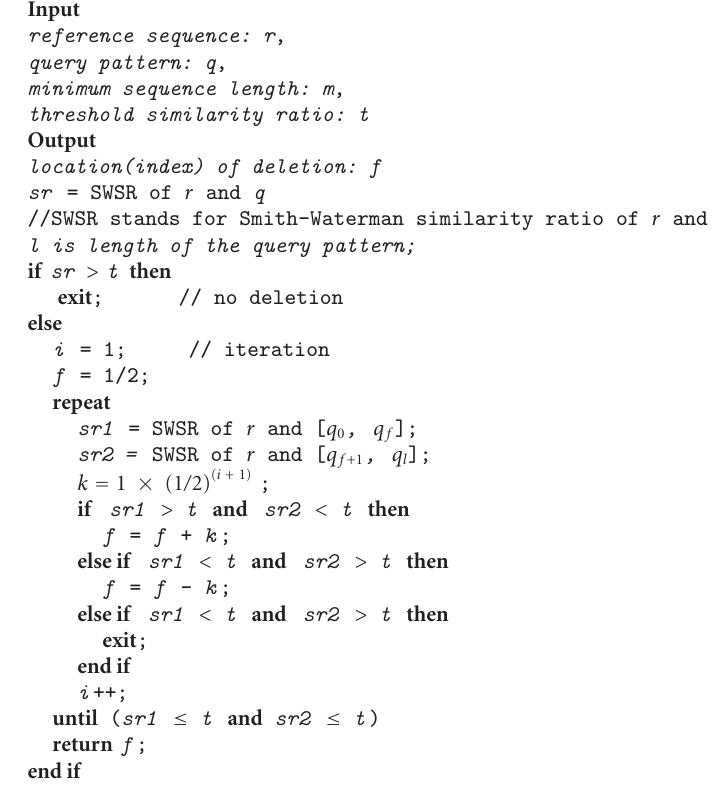
Algorithm 2: BinaryPartialAlign pseudocode.